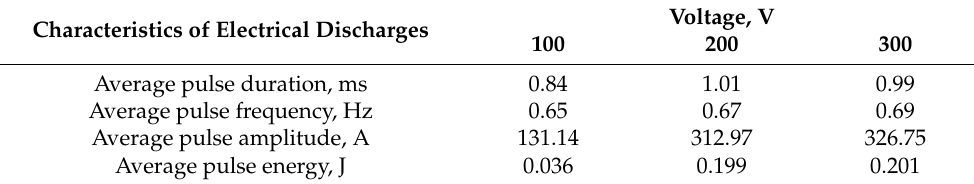
Table 2. Electric discharge parameters with the control of the pulse duration.